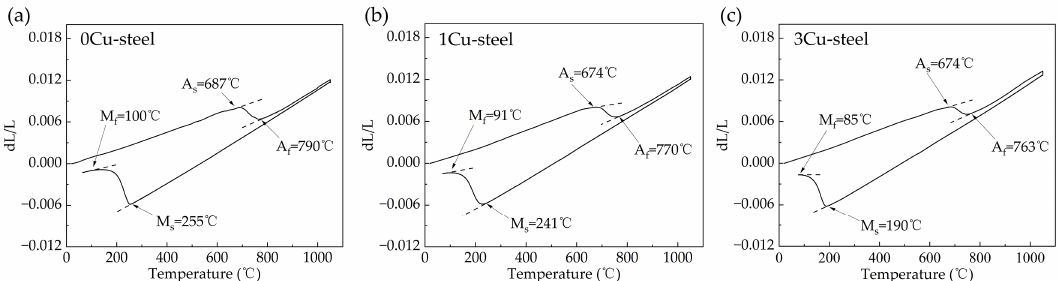
Figure 1. Thermal expansion curves of the three steels with different Cu content: ( a ) 0Cu, ( b ) 1wt.% Cu, and ( c ) 3wt.% Cu. Table 2. The phase transition points of the three steels.